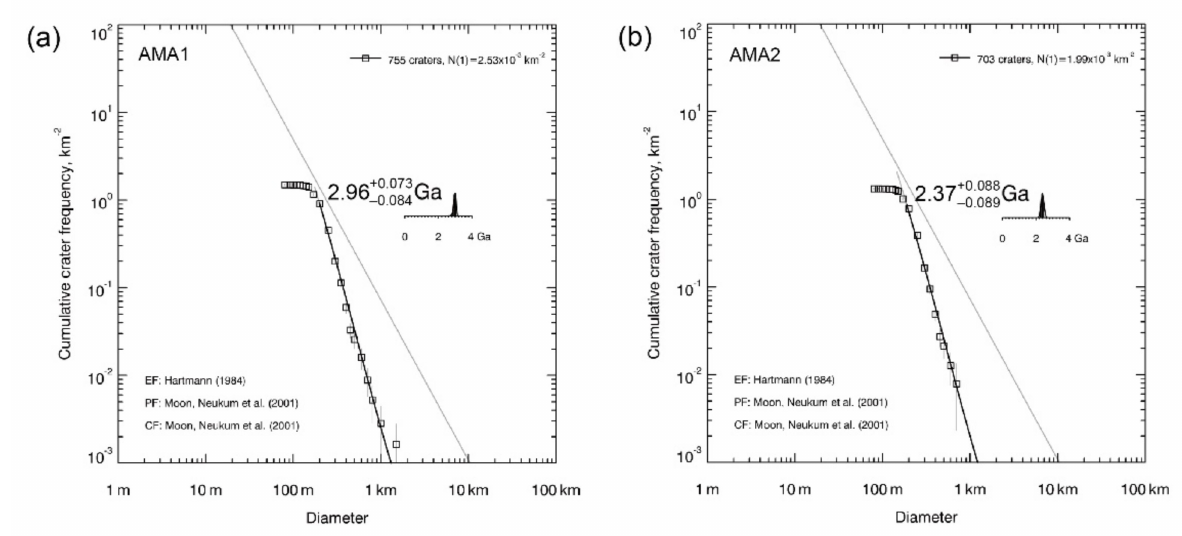
Figure 10. AMAs of the area contaminated by external ejecta before ( a ) and after ( b ) secondary craters were removed based on the crater morphology. Location of the area is shown as the blue square in Figure